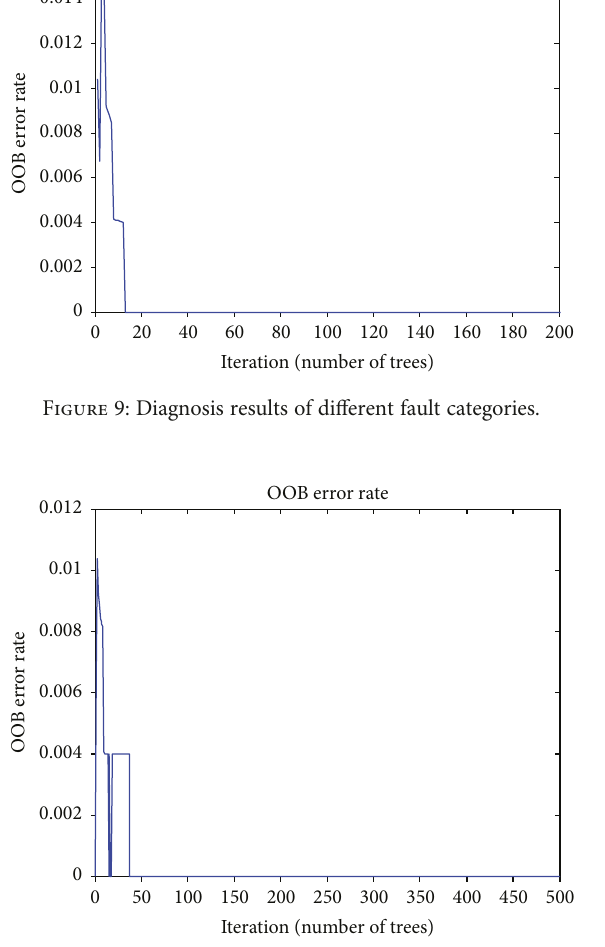
Figure 10: Diagnostic results at di ff erent levels of the same